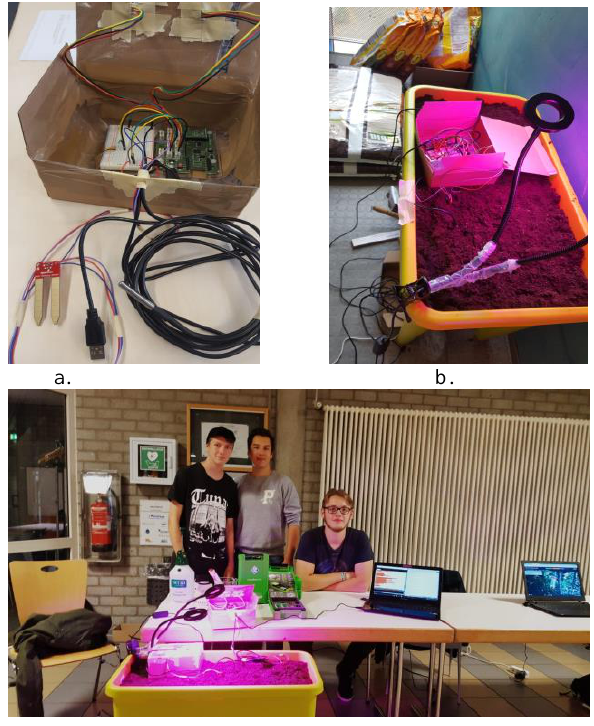
Figure 3: a. sensors to be put inside the plastic box field and their connection for senseBox, b. plastic box simulated as salad plants field filled with soil and necessary sensors connection, c.